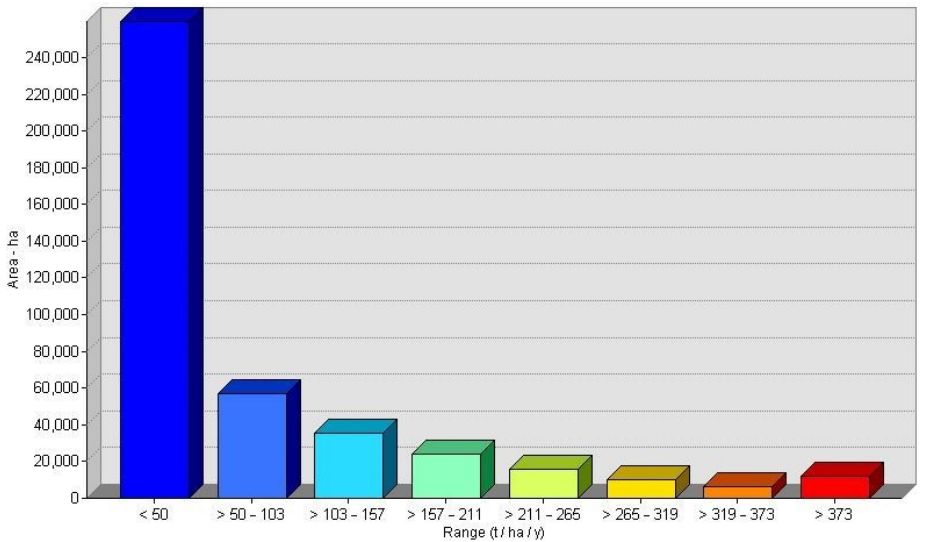
Figure 8. Frequency of SE classes.